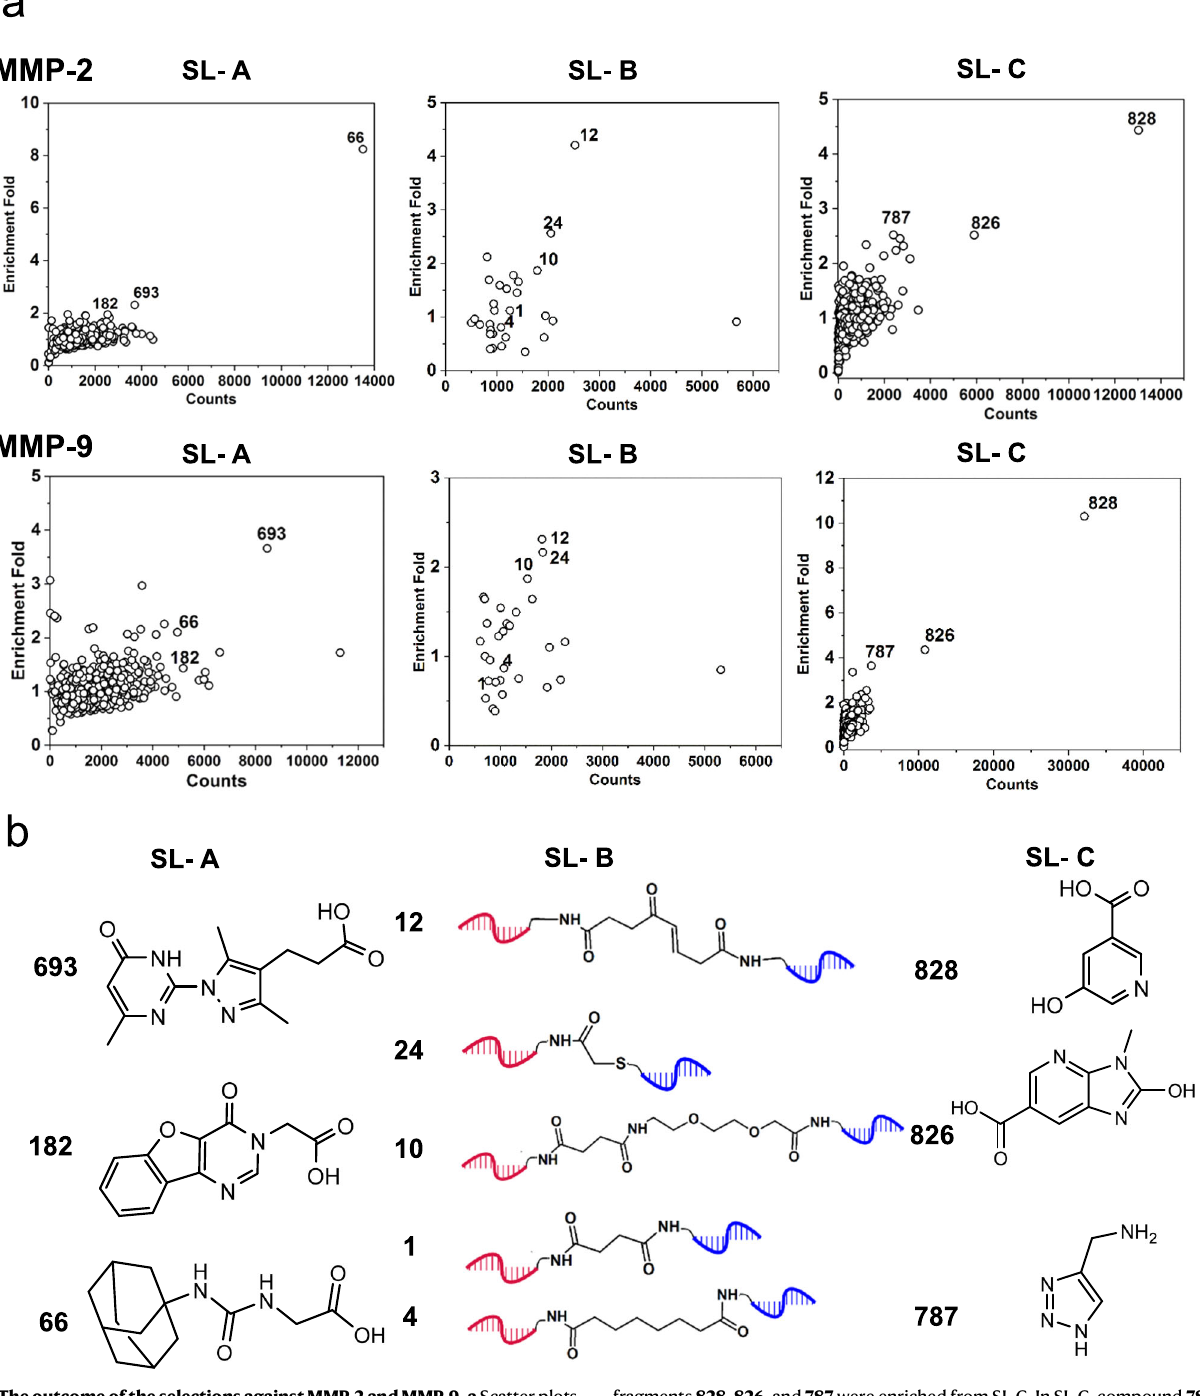
Fig.4|TheoutcomeoftheselectionsagainstMMP-2andMMP-9.a Scatterplots of selection results from sub-libraries A, B, and C. b Structures of the